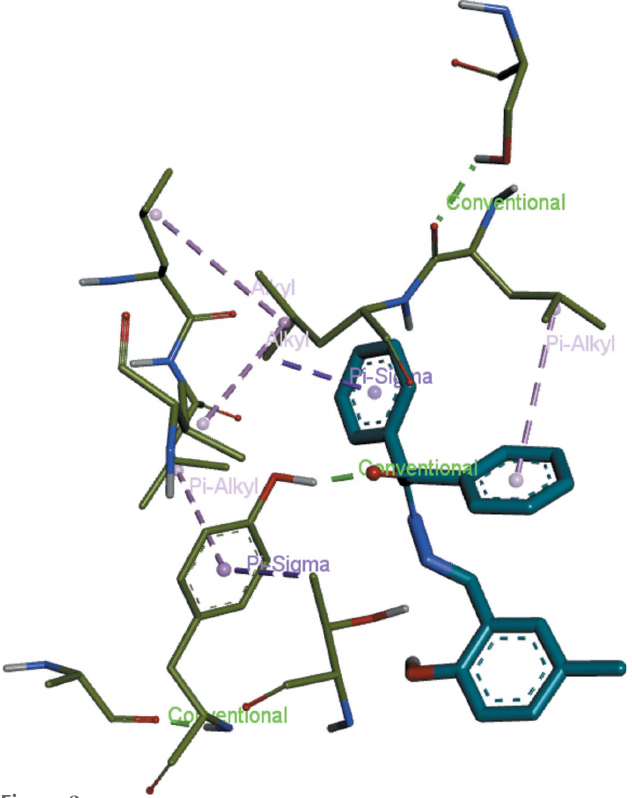
Figure 3 Three-dimensional visualization of the intermolecular interactions for the best binding pose of the title compound docking with 6LU7.